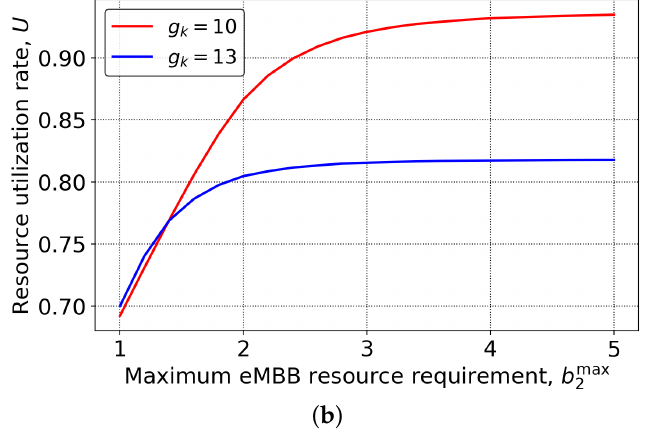
Figure 5. System resource utilization: ( a ) varying ρ 1 , ( b ) varying b max